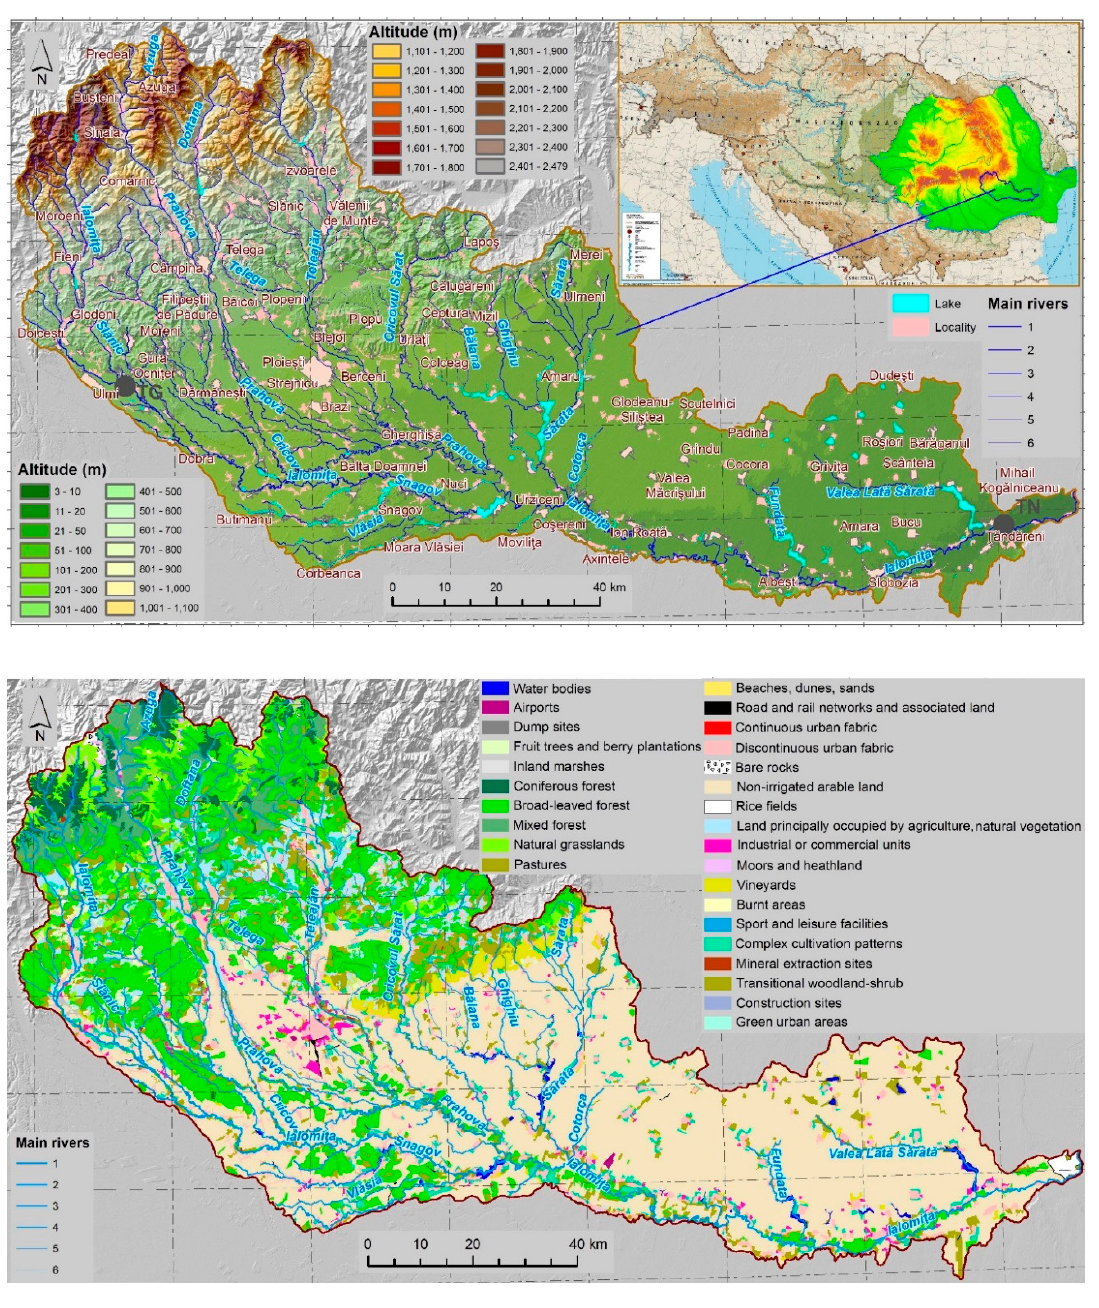
Figure 1. Hydrographical network and land cover in Ialomita River Basin (Source of data: https://www.danubecommission.org/uploads/images/Duna-2009-1-1-000-000-2500-.jpg and https://land.copernicus.eu/pan-european/corine-land-cover/clc2018). Table 1. Multiannual hydrological parameters recorded in various control sections of Ialomita River Basin and its major tributary Prahova River (see water management scheme—Figure S1); a.BS.l— above Black Sea level.